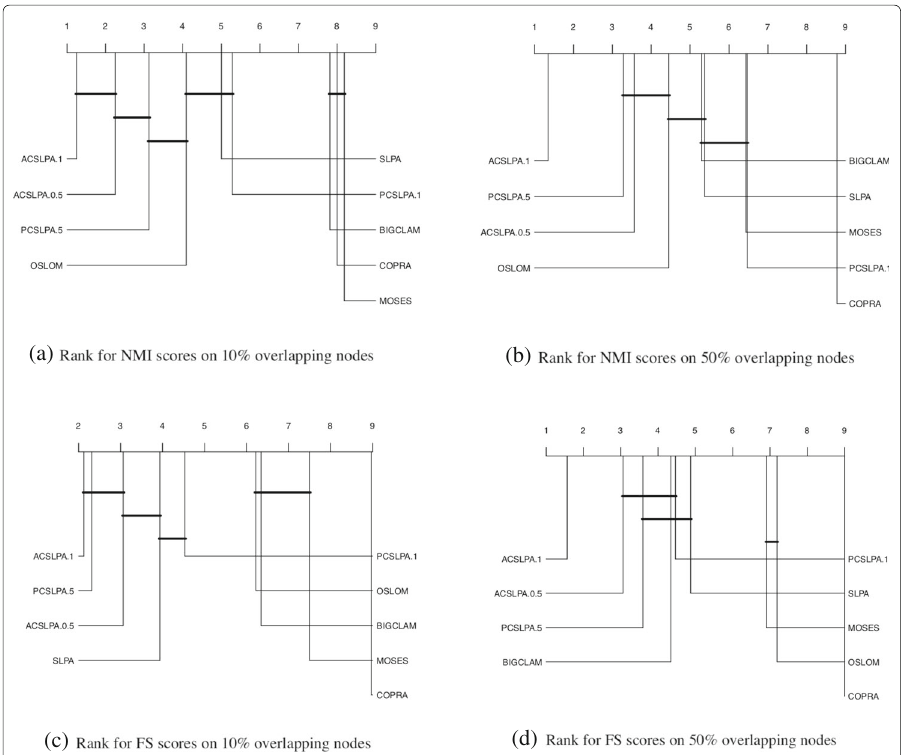
Fig. 7 Rank plots from Friedman Aligned rank tests with Finner p -value adjustment, for NMI and F-Measure (FS). Algorithms which are not connected with a horizontal line are significantly different over all synthetic networks, with a significance level of α =